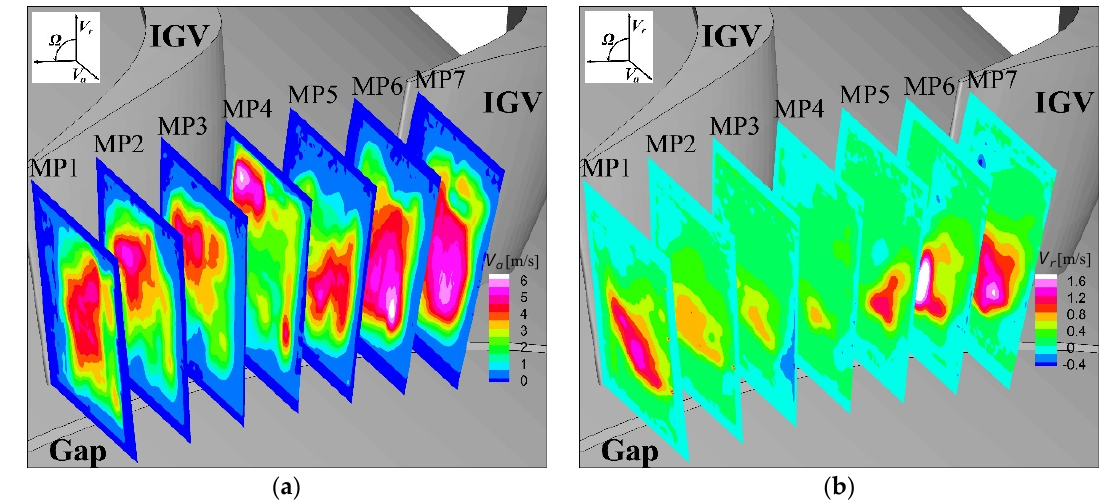
Figure 6. Time-averaged flow structure of the inter-stage flow in Case 2, C s = 1.1 × 10 4 . ( a ) V a ; ( b ) V r Figure 6. Time ‐ averaged flow structure of the inter ‐ stage flow in Case 2, (cid:1829) (cid:3046) (cid:3404) 1.1 (cid:3400) 10 (cid:2872) . ( a ) (cid:1848) (cid:3028) ; ( b ) (cid:1848) (cid:3045) .